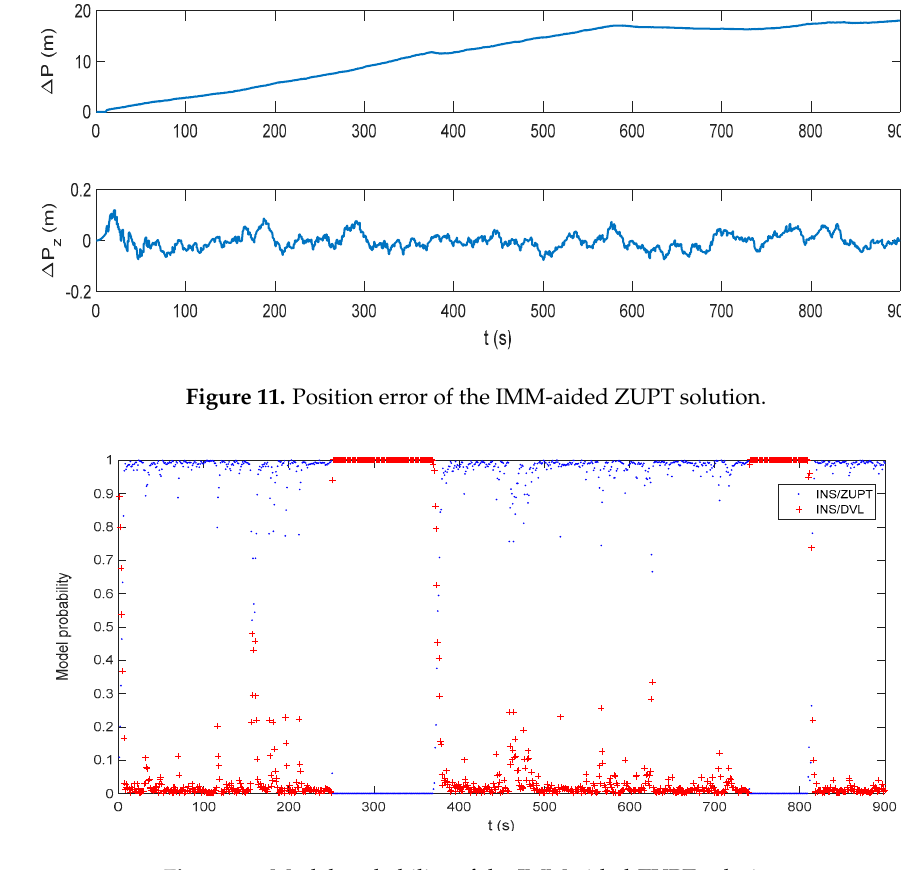
Figure 10. Velocity error of the IMM-aided ZUPT solution.